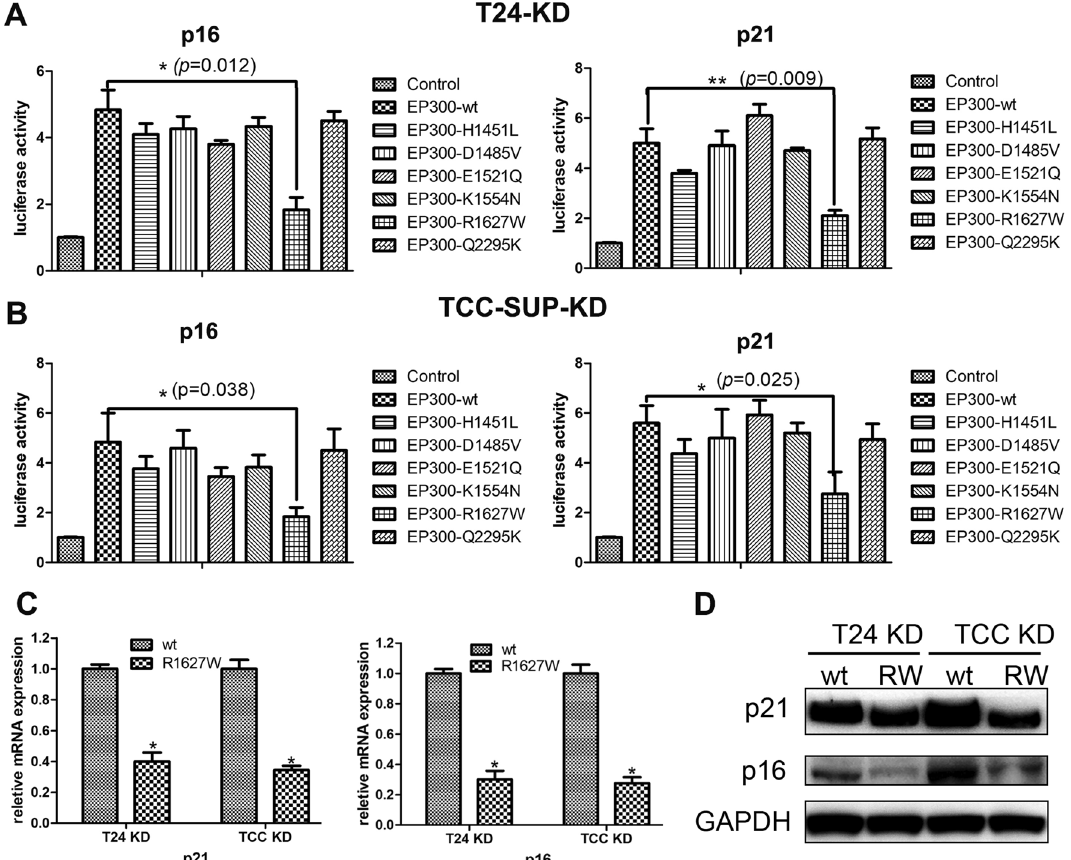
Fig. 3 EP300-R1627W mutation impairs EP300 transactivation activity on both the p21 and p16 promoters. A , B Luciferase assays show that EP300-R1627W mutation impairs EP300 transactivation activity on both the p21 and p16 promoters in T24 and TCC-SUP. The bar graph shows results as relative activity compared to the control activity. C , D mRNA and protein expression of p21 and p16 after transfection of EP300-wt and EP300-R1627W plasmids in T24-EP300kd cells and TCC-SUP-EP300kd cells,